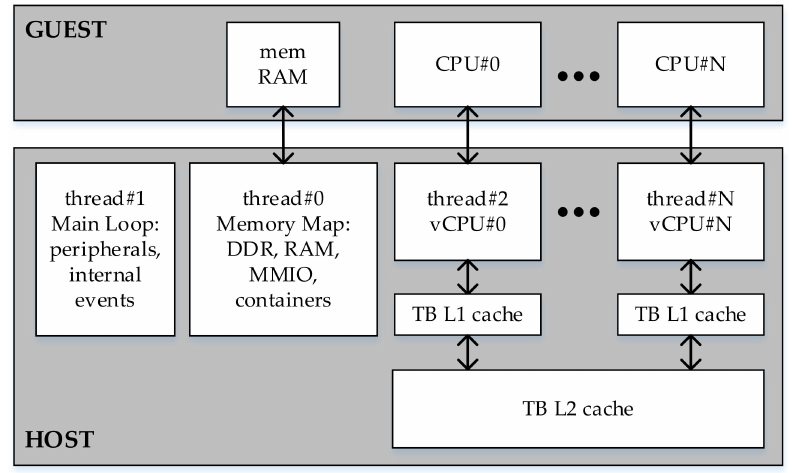
Figure 2. Quick EMUlator(QEMU)-MTTCG internal